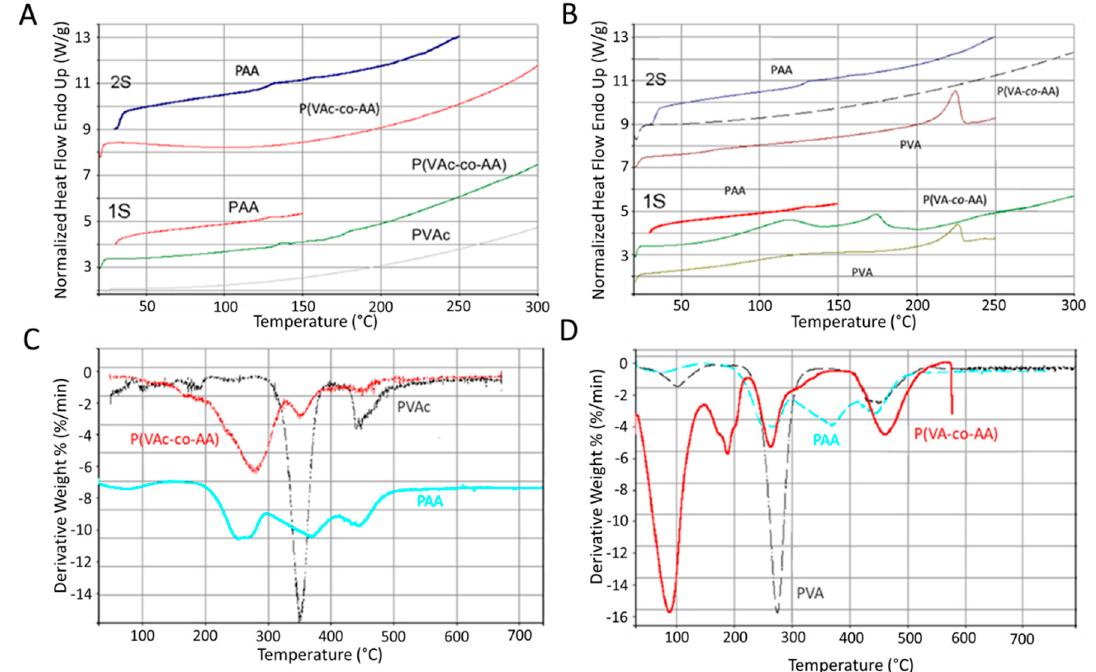
Figure 1. Di ff erential scanning calorimetry (DSC) thermograms of P(VAc- co -AA) and pure components, first and second scan ( A ); DSC thermograms of P(VA- co -AA) and pure components, first and second scan ( B ); TGA / DGA traces of P(VAc- co -AA) and pure components ( C ); TGA / DGA traces of P(VA- co -AA) and pure components ( D ).